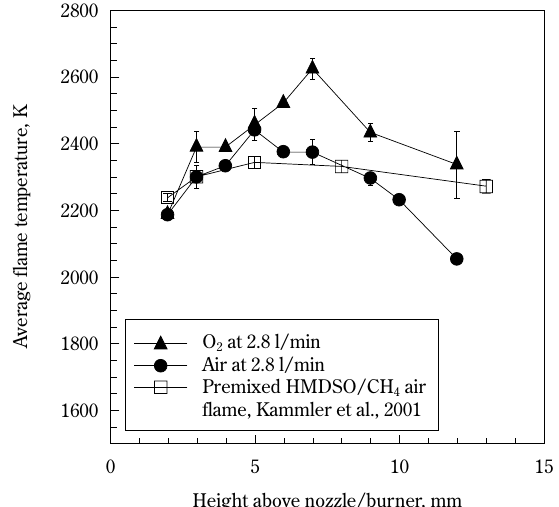
Comparison of the measured axial temperature profiles of a silica-producing premixed vapor flame [2] and a self-sus- taining spray flame [74]. The maximum flame tempera- ture in both flames is very high and rather similar. The high velocities in the spray flame leads to faster cooling compared with the premixed vapor